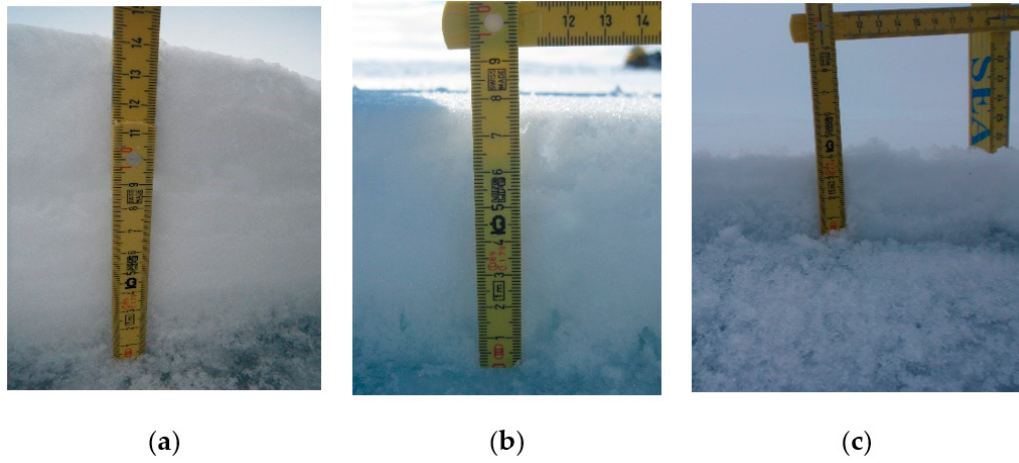
Figure 4. Sample snow cover on first-year sea ice (FYI) located adjacent to the scatterometer scan area: ( a ) 14 cm; ( b ) 8 cm; and ( c ) 4 cm. Table 1. Snow cover and sea ice thermophysical properties for the 14 cm snow cover on smooth FYI for 19 May 2012. The total sea ice thickness was 1.3 m, and “sea ice” in the table represent the topmost 2 cm frazil ice core section. Note that snow and sea ice thermophysical properties for the 14 cm snow cover used here are adopted from Table 2 in [14].